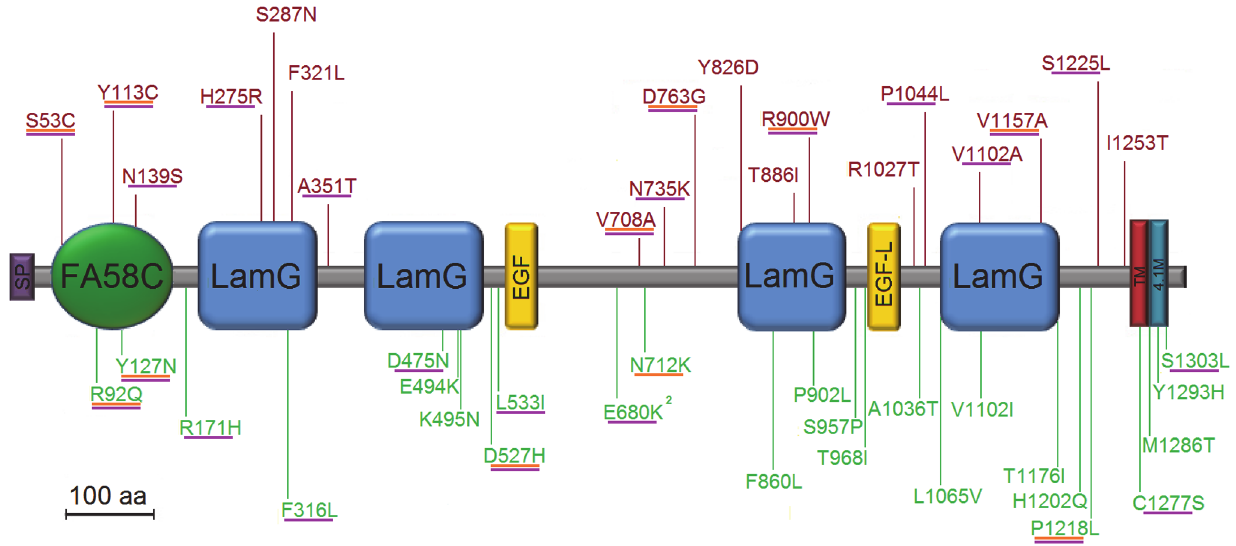
Figure 1. Location of all mutations of interest, i.e. rare and exclusive to cases or controls. Mutations were counted if missense, nonsense, splice site, or frameshift in CNTNAP2 (in point of fact, all were missense). Variants in red are exclusive to cases; those in green, controls. Those predicted to be deleterious in SIFT are underlined in orange; in PolyPhen2, purple. Domain names and approximate locations from Bakkaloglu et